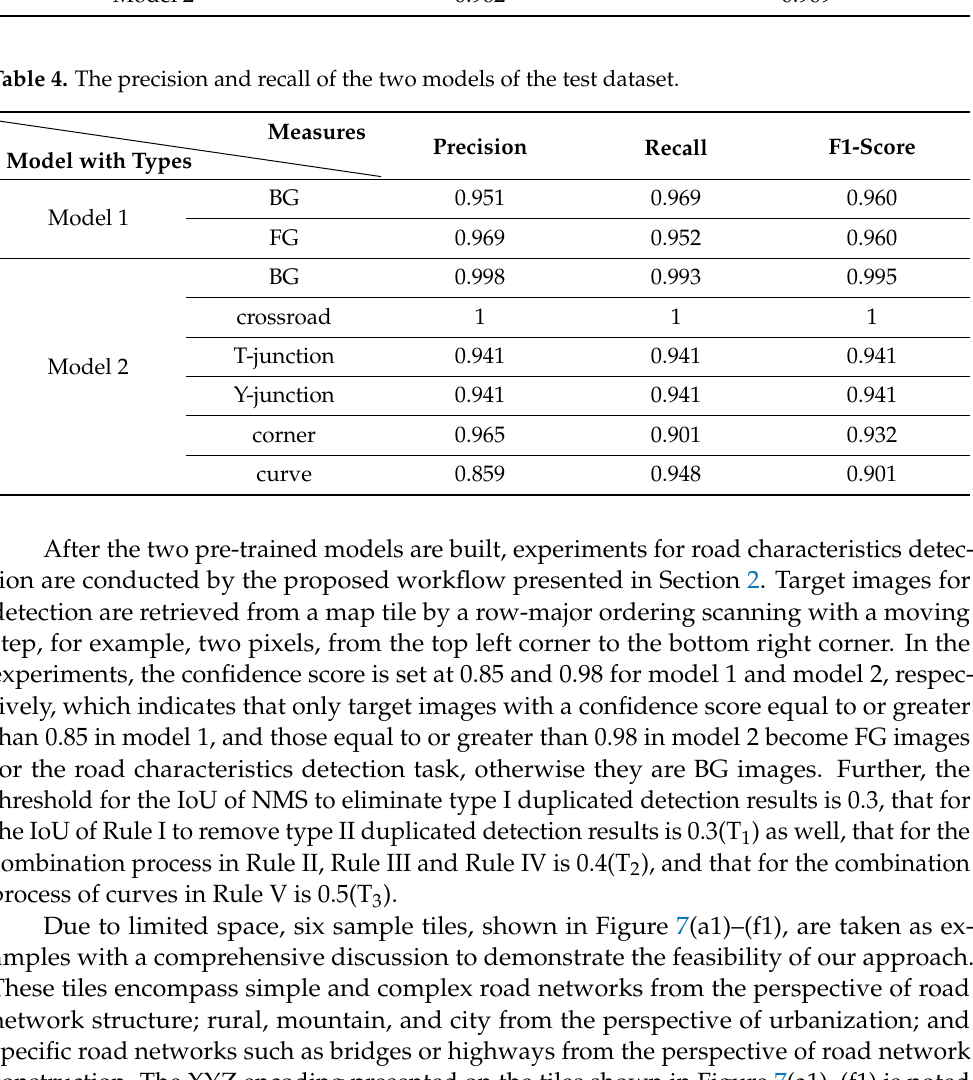
Table 4. The precision and recall of the two models of the test dataset.